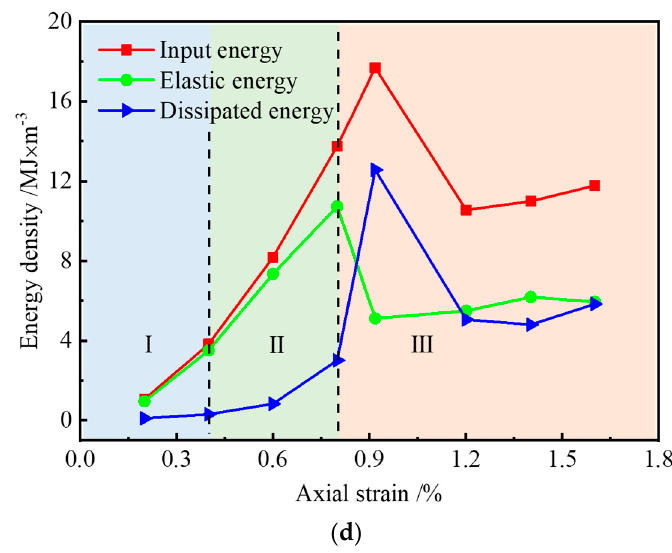
Figure 9. The evolution of energy density with axial strain under different gas pressures ( Ⅰ, the compaction and linear elastic stage; Ⅱ, the yield stage; Ⅲ, the post-peak stage). ( a ) Gas pressure 0 MPa, ( b ) gas pressure 1 MPa, ( c ) gas pressure 2 MPa, and ( d ) gas pressure 3